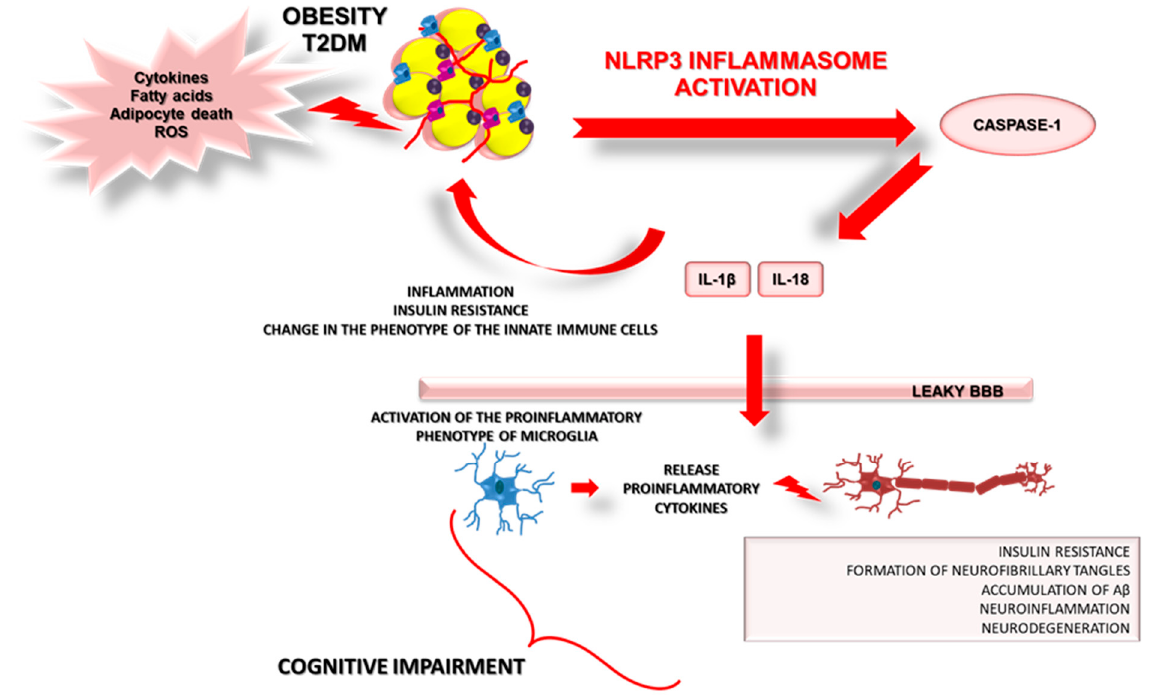
Figure 4. Potential mechanisms linking inflammation with obesity, NLRP3 inflammasome pathway, peripheral and central insulin resistance, and Alzheimer’s Disease. Details in the text.